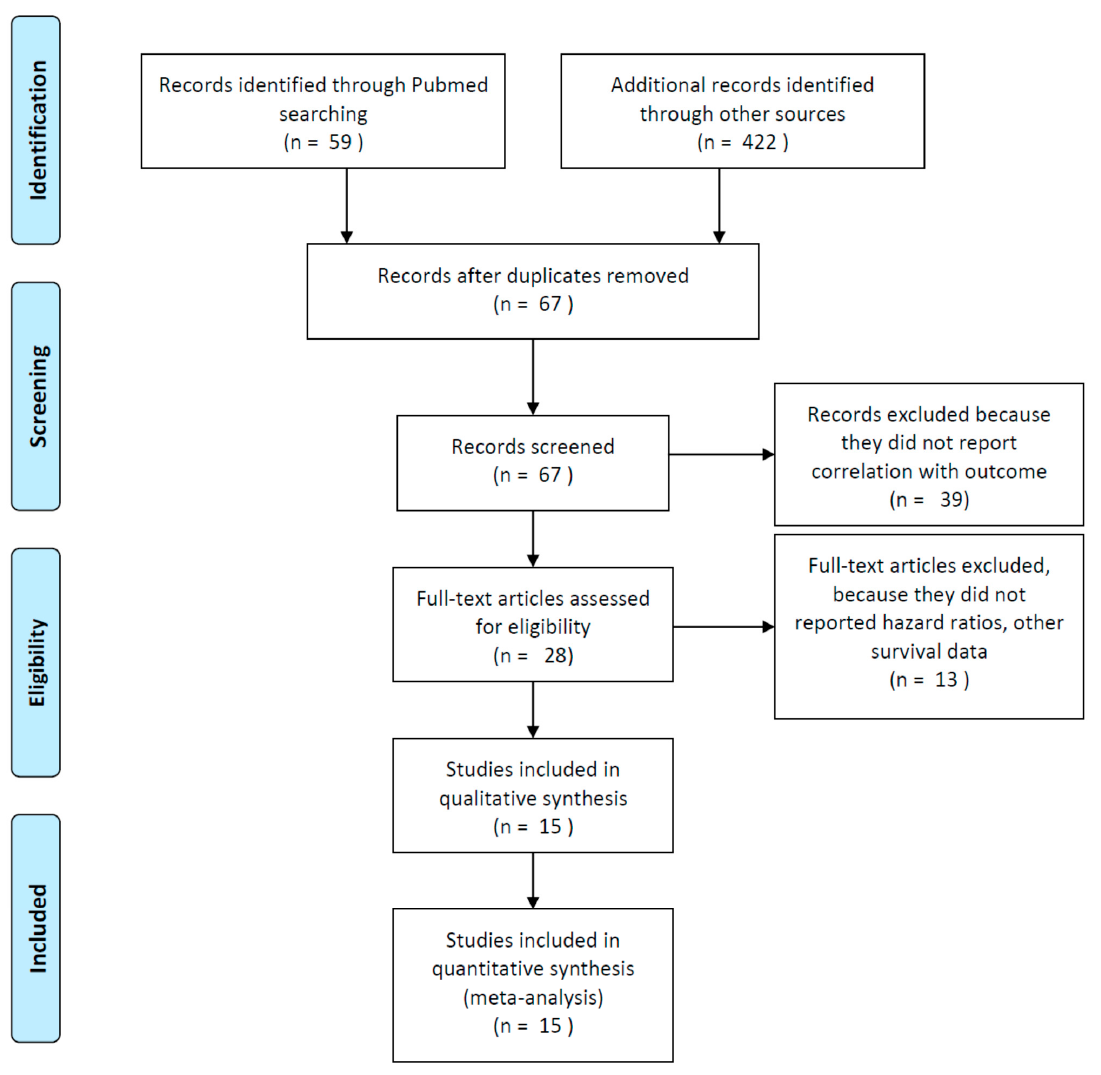
Figure 1. Flow diagram of included